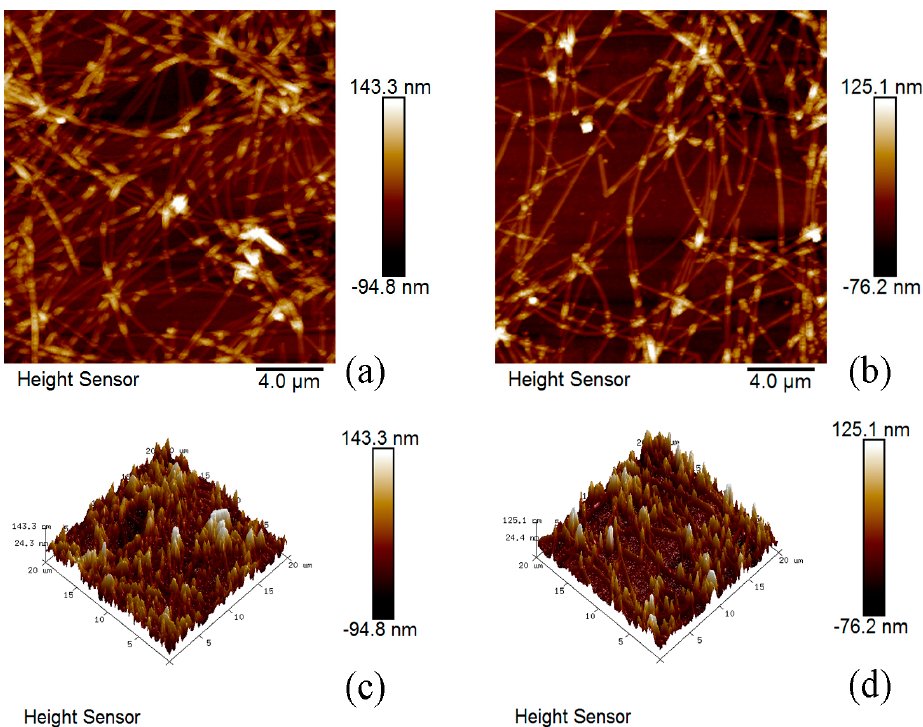
Figure 5. AFM images of AgNWs-TCF before and after moisture treatment: ( a ) AFM images of AgNWs-TCF before moisture treatment, ( b ) AFM images of AgNWs-TCF after moisture treatment; ( c ) and ( d ) correspond to the 3D images in ( a ) and ( b ), respectively.